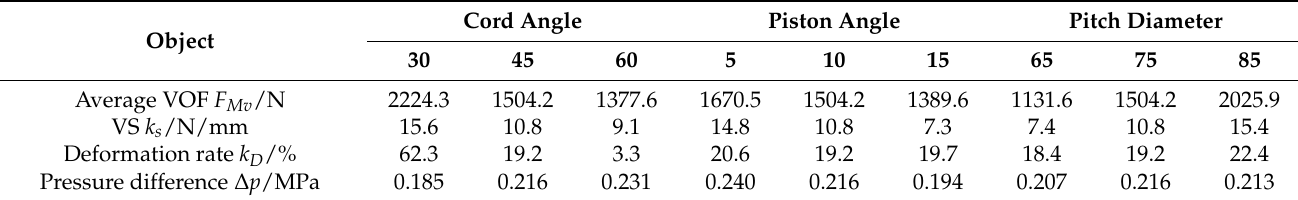
Table 4. Single-factor simulation scheme.